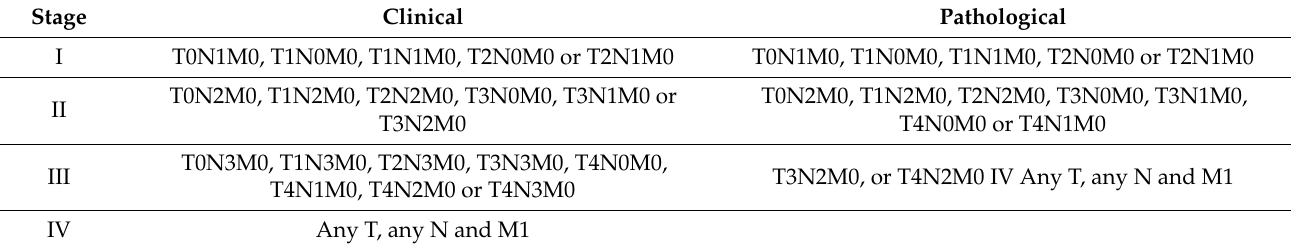
Table 1. AJCC prognostic clinical or pathological stage groups for HPV-related (p16-positive) oropharyngeal cancers [10,11]. Stage Clinical